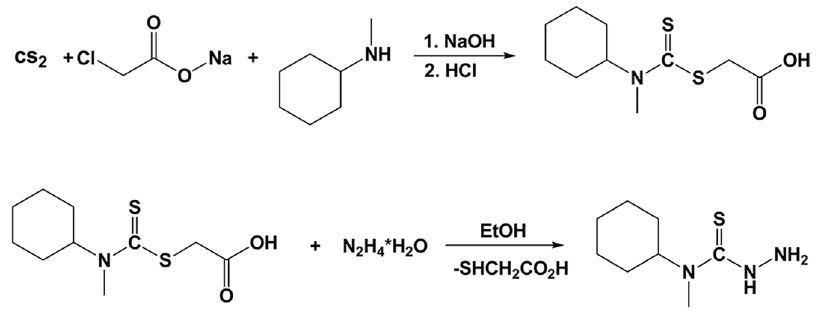
Figure 3. Synthetic route to yield the thiosemicarbazide, f.